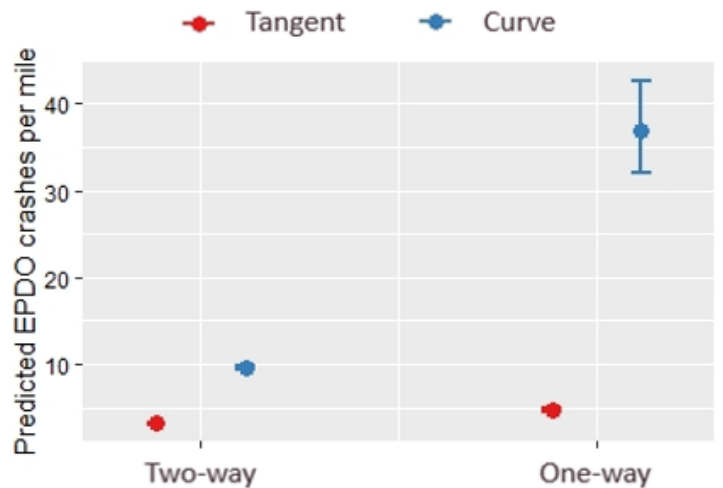
Figure 3 Probability of EPDO crashes per mile depending upon road operation and segment